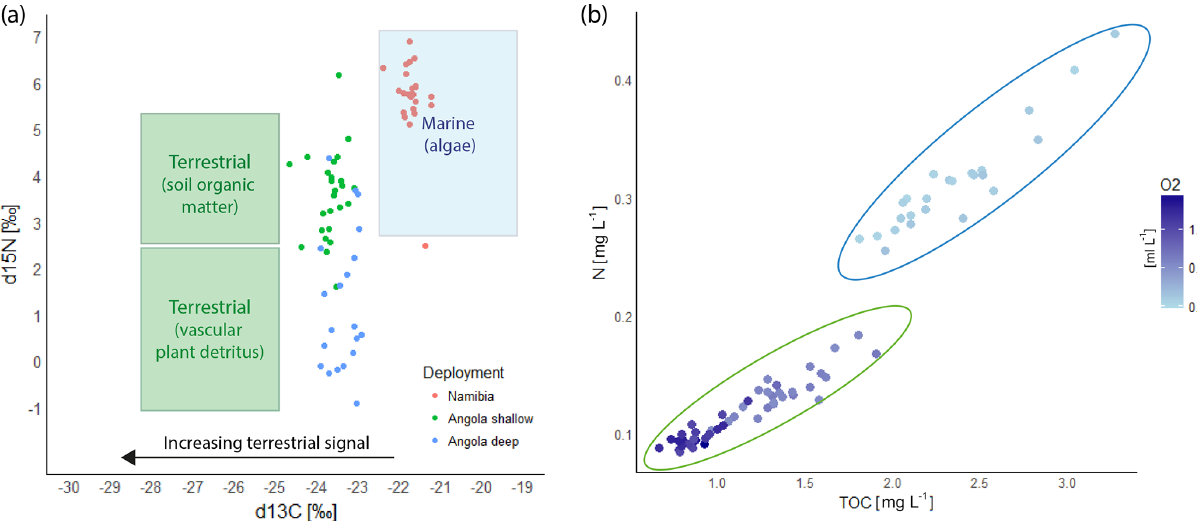
Figure 8. Composite records of SPOM collected by the McLane pump of the ALBEX lander at the Namibian and Angolan margins during all three deployments. (a) δ 15 N and δ 13 C isotopic values at the Namibian (red dots) and Angolan (blue and green dots) margins. Indicated by the square boxes are common isotopic values of terrestrial and marine organic matter (Boutton, 1991; Holmes et al., 1997; Sigman et al., 2009). The relative contribution of terrestrial material (green boxes) is increasing with a more negative δ 13 C value. (b) Total organic carbon (TOC) and nitrogen (N) concentration of the SPOM. Values of the Namibian margin are marked by a blue circle (C / N ratio = 7.8), values of the Angolan margin are marked by a green circle (C / N ratio = 9.6). Dissolved oxygen concentrations are included to show the higher nutrient concentrations in less oxygenated